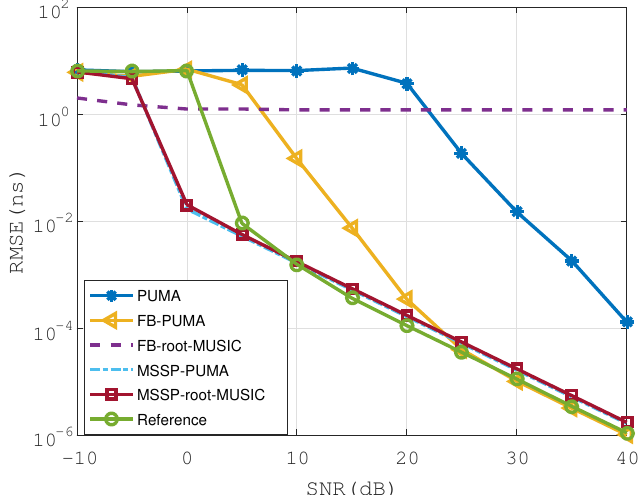
Figure 7. RMSE versus SNR, K = 3, fully correlated echoes (Scenario 3).